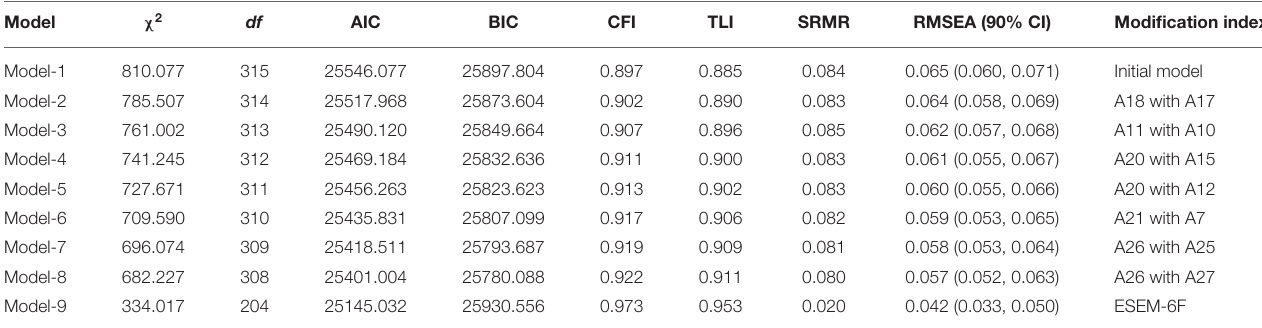
TABLE 4 | Model fit indices for nine Exercise Orientation Questionnaire (EOQ)